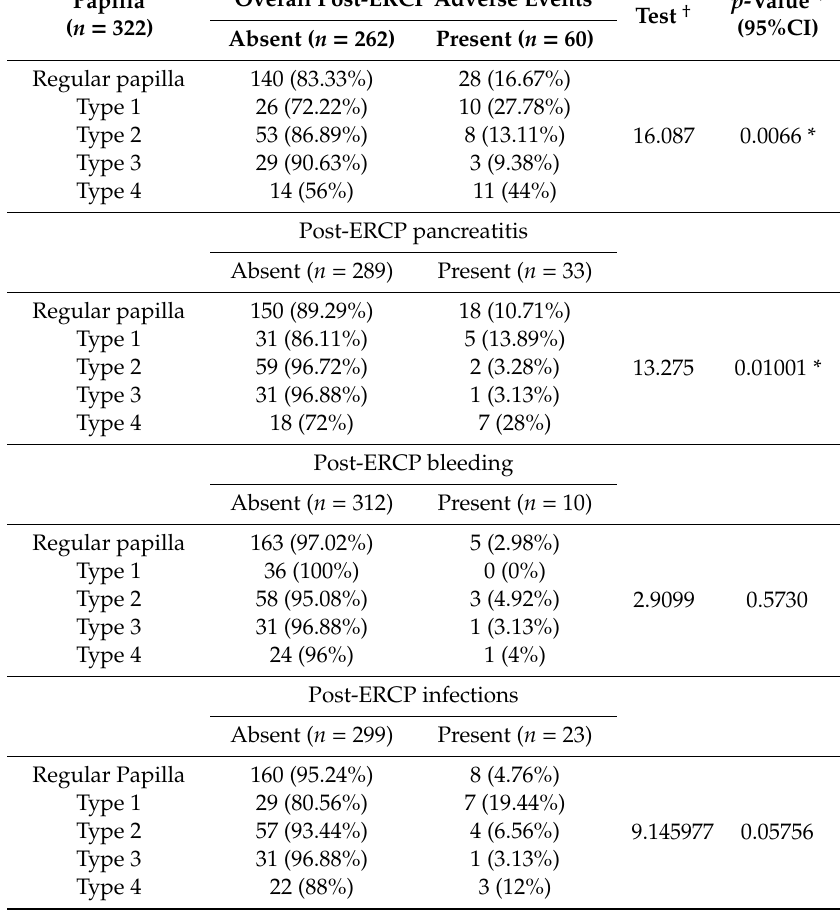
Table 4. Correlations between the di ff erent alternative papillotomy techniques and the endoscopic appearances of the papilla. Rescue Papillotomy Techniques Papilla Needle-Knife Needle-Knife Transpancreatic Biliary Freehand Precut Fistulotomy Sphincterotomy Regular